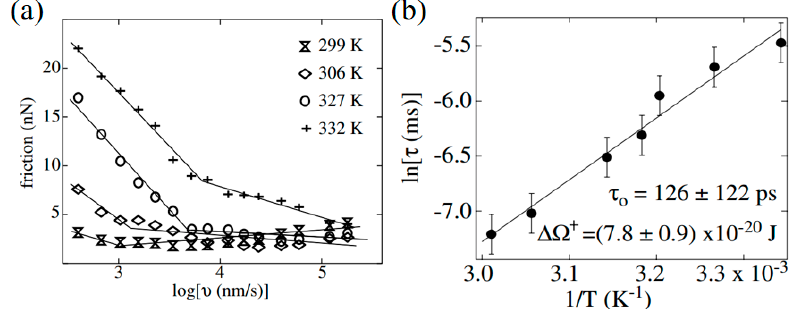
Figure 16. ( a ) The variation of friction with velocity at different temperatures. The load was 15 nN, the tip radius was 25 nm, the RH was at 37% ± 2%. ( b ) By fitting the data to calculate the attempt frequency and energy barrier. Reprinted from Ref. [102], Copyright 2005, with permission from APS publications.